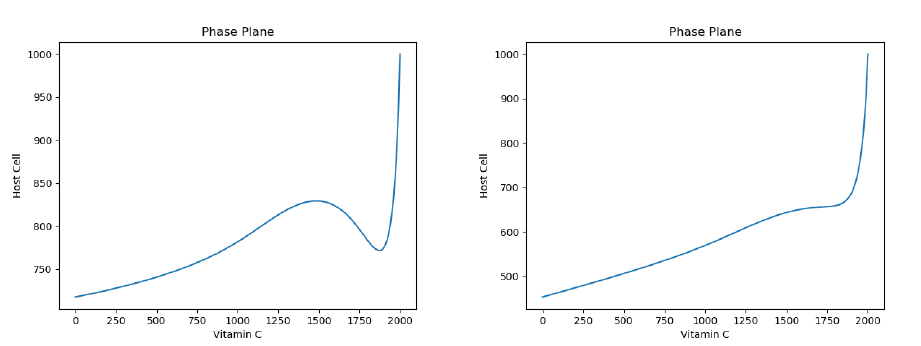
Figure 6. Phase Plane Comparison of Healthy (left) and Frustrated Phagocytosis (right) States